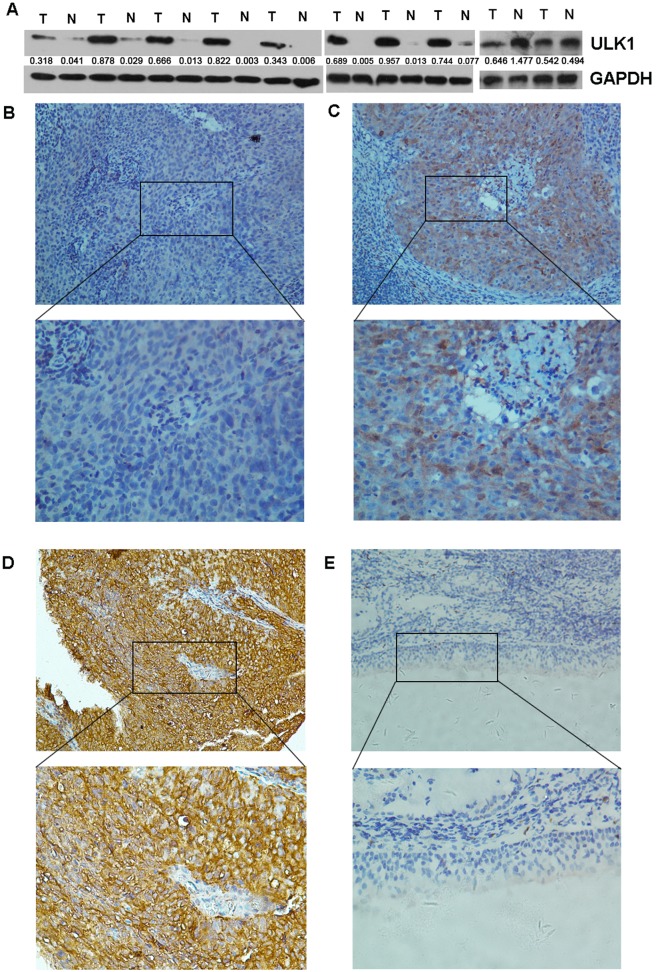
The expression of ULK1 in NPC tissues.(A) Western blot analysis of ULK1 protein expression in 10 representative paired of NPC (T) and adjacent normal mucosa tissues (N). Equal loading of protein was determined by GAPDH. The number below indicated the expression level of ULK1 relative to GAPDH in each samples. (B) An NPC case demonstrated low expression of ULK1, in which negative immunohistochemistry staining was observed in all the NPC cells (upper panel ×200). (C) An NPC case showed moderate ULK1 staining (upper panel ×200). (D) Strong ULK1 IHC signaling was detected in the cytoplasm pattern of the NPC cancer cells (upper panel ×200). (E) Normal nasopharyngeal mucosa tissue showed negative expression of ULK1 protein (upper panel ×200). The lower panels indicated the higher magnification (× 400) from the area of the box in B., C., D. and E., respectively.